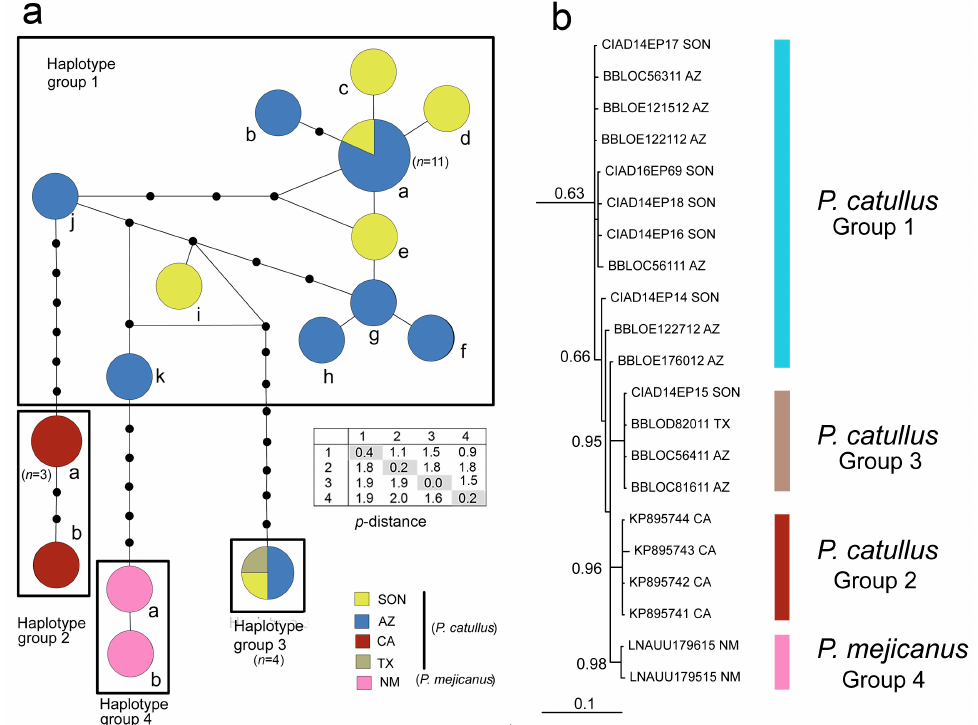
Figure 3. ( a ) TCS haplotype network of COI barcodes in Pholisora showing clustering of haplotypes into four groups. Different haplotypes in each group are identified with letters corresponding to those shown in Table 1. Numbers next to circles represent the number of individuals with that haplotype, if greater than one. Each line segment between haplotypes represents a single mutation. Inferred intermediate haplotypes that were not sampled are shown as black dots. Size of the circles is scaled approximately to haplotype frequency. State abbreviations: SON, Sonora (Mexico); AZ, Arizona; CA, California; TX, Texas; NM, New Mexico. Table inset shows mean pairwise p -distances (%) among groups 1 to 4 below the diagonal; shaded values shown along the diagonal are mean within-group p -distances; minimum pairwise p -distances among groups are shown above the diagonal. ( b ) Bayesian 50% majority rule consensus tree of barcode sequences showing clustering of the four COI haplotype groups (outgroups not shown). Clade support values (posterior probabilities) for the major clades are shown adjacent to branches. The scale represents expected substitutions per site.